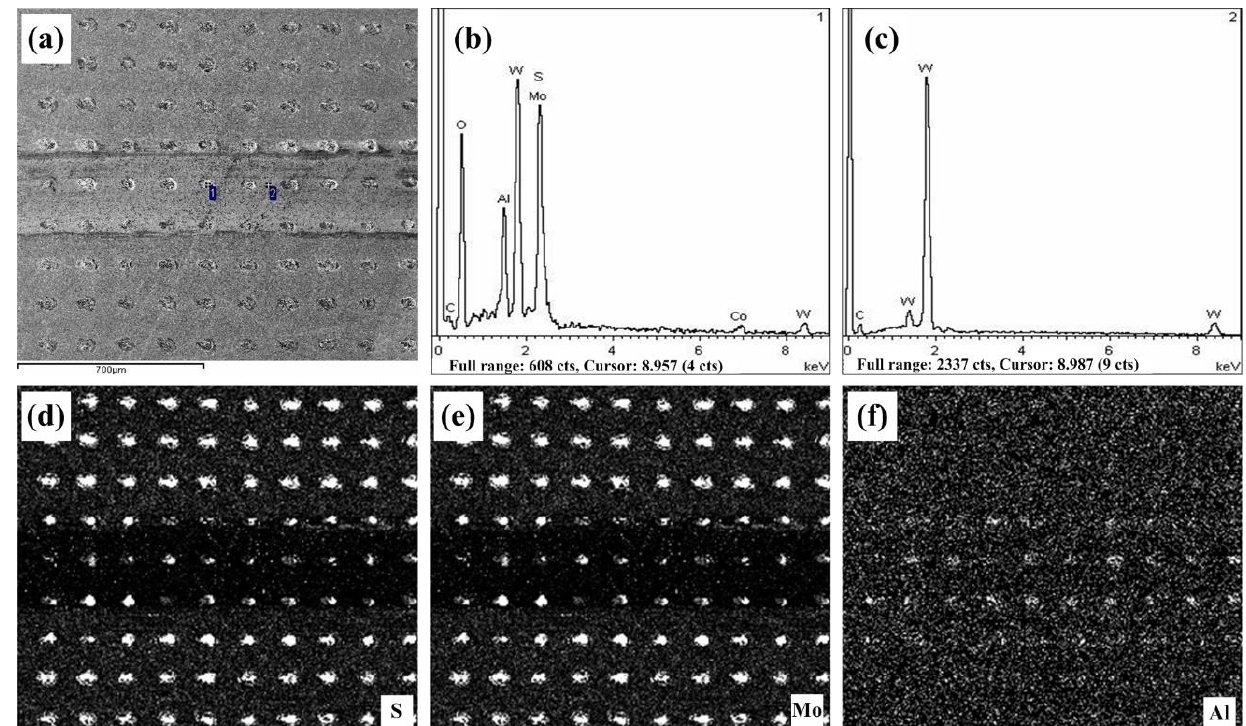
Figure 12. Worn surface and component analysis for TD150 filled with lubricants at sliding speed of 40 m/min: ( a ) SEM micrograph, ( b ) XRD for point 1, ( c ) XRD for point 2, ( d ) EDS map of S element,